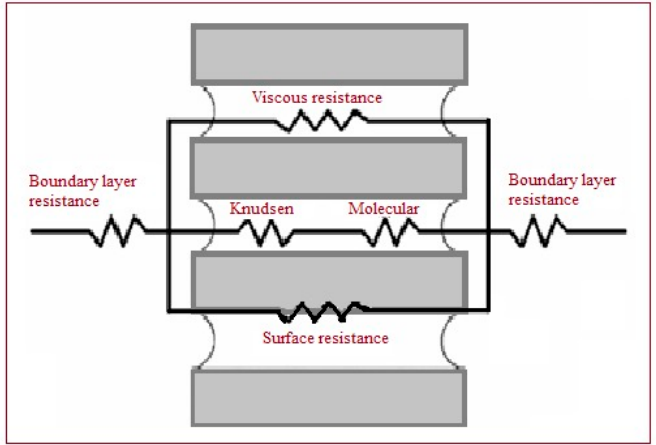
(16) Molecular diffusion model: 𝐽 (cid:3014) = 𝜀𝐷 (cid:3050)(cid:3028) 𝜏𝛿 (cid:3040) 𝑃𝑀 (cid:3050) 𝑅𝑇 (cid:3040) 𝑙𝑛 (cid:3436)𝑃 − 𝑃 (cid:3049)(cid:2869) 𝑃 − 𝑃 (cid:3049)(cid:2870) (cid:3440) (17) Knudsen molecular diffusion transition model: 𝐽 (cid:3012)(cid:2879)(cid:3014) = 𝜀𝑀 (cid:3050) 𝜏𝛿 (cid:3040) 𝑃𝐷 (cid:3050)(cid:3028) 𝑅𝑇 (cid:3040) 𝑙𝑛